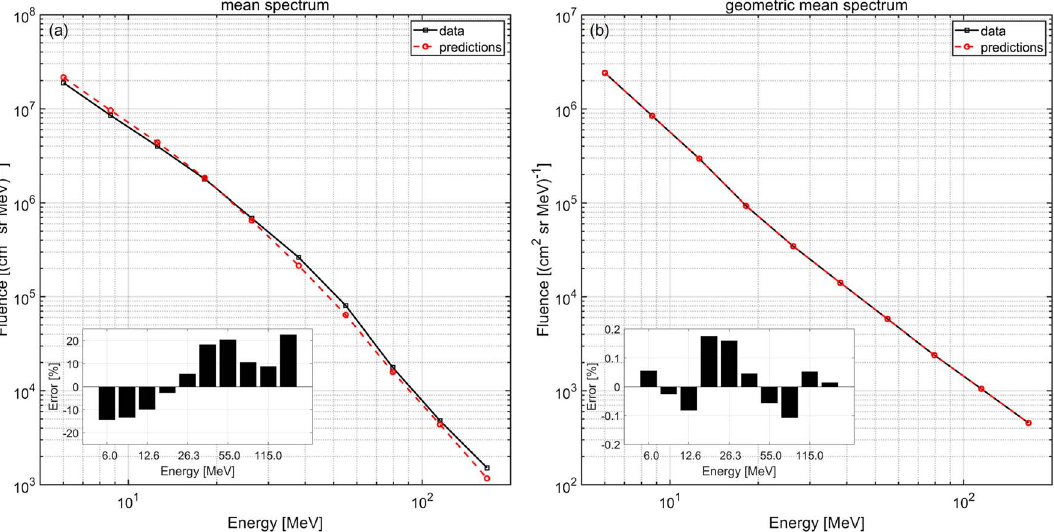
Fig. 11. Comparison of (a) mean spectra and (b) geometric mean spectra of Fluences from all Events in the SEPEM REL and all predicted Fluences in this work. Insets show percentage error at all energy bins.